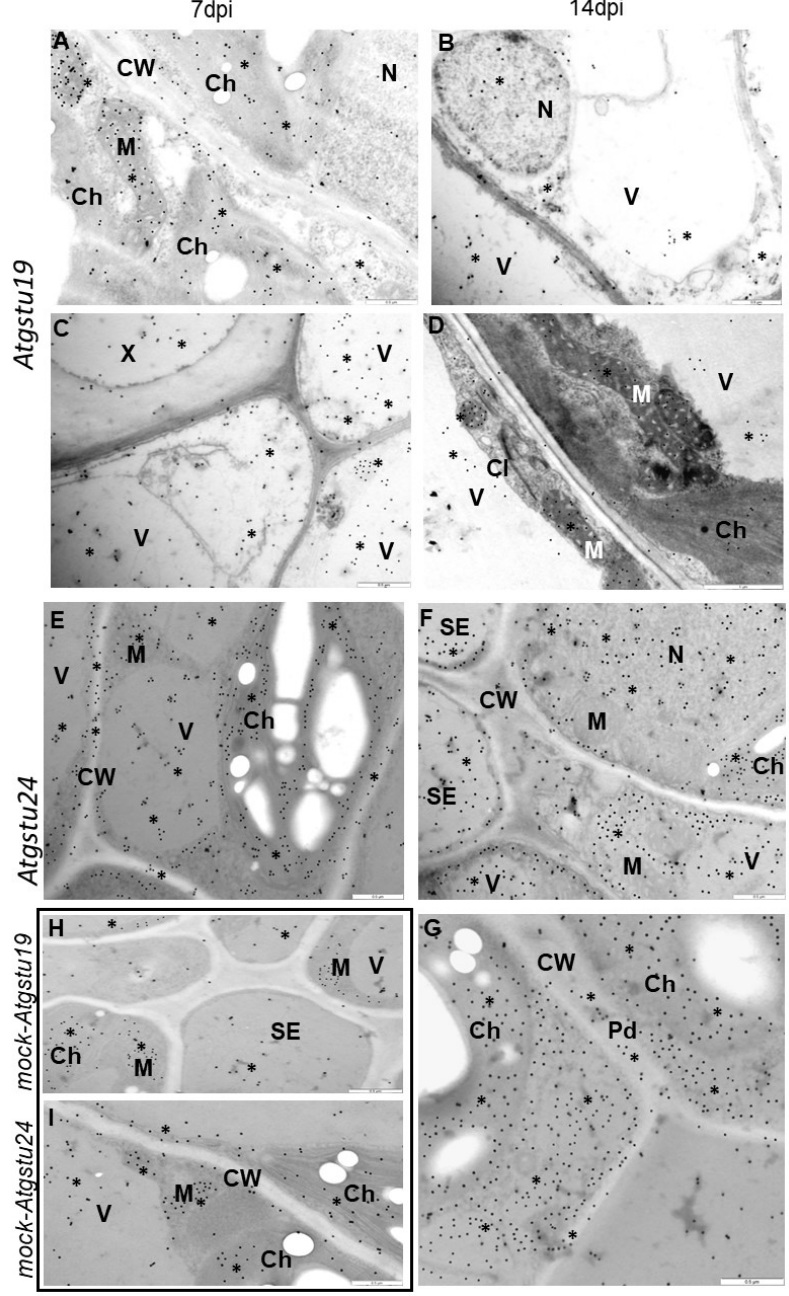
Figure 6. Immunogold labeling of glutathione deposition in Atgstu19 ( A – D ) and Atgstu24 ( E – G ) 7 dpi ( A , C , E ) and 14 dpi ( B , D , F , G ) after TuMV and mock ‐ inoculation (in frame H – I ) leaves. ( A ) Glutathione (*) deposition in chloroplast (Ch), mitochondria (M) and cytoplasm of mesophyll cells. Scale bar 0.5 μ m. ( B ) Glutathione (*) in nucleus (N) and cytoplasm of mesophyll cell. Scale bar 0.5 μ m. ( C ) Glutathione (*) in vacuole (V), cytoplasm and xylem tracheary element (X) in xylem tissue. Scale bar 0.5 μ m. ( D ) Glutathione (*) deposition in mitochondria (M), chloroplast (Ch) and vacuole (V) in palisade mesophyll. Virus cytoplasmic inclusions (CI) present in mesophyll cell. Scale bar 1 μ m. ( E ) Glutathione (*) deposition in chloroplast (Ch), cytoplasm, vacuole (V). Glutathione (*) de ‐ posited in cell wall (CW) of mesophyll cell. Scale bar 0.5 μ m. ( F ) Glutathione (*) deposition in nu ‐ cleus (N), chloroplast (Ch) and cytoplasm of phloem cells. Glutathione (*) deposition presented also